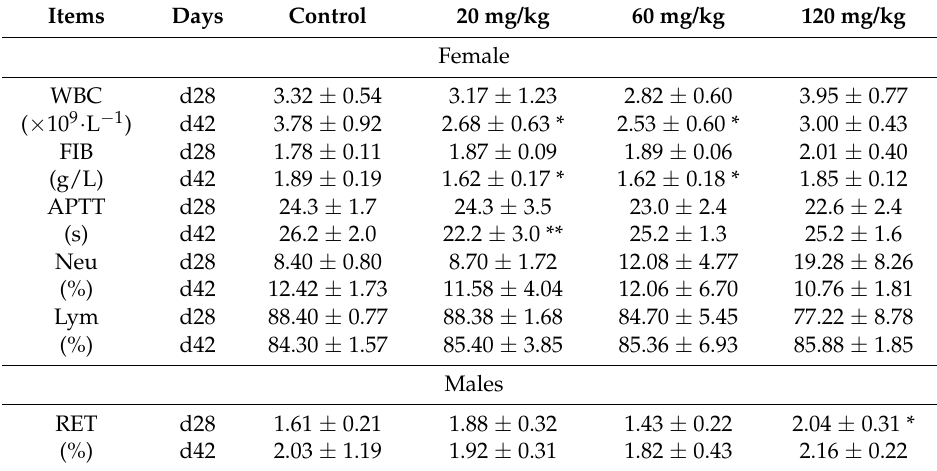
Table 7. Selected hematological parameters induced by HZ1006 in rats following repeated dose administration during the study of subchronic toxicity (only significant results are listed). Items Days